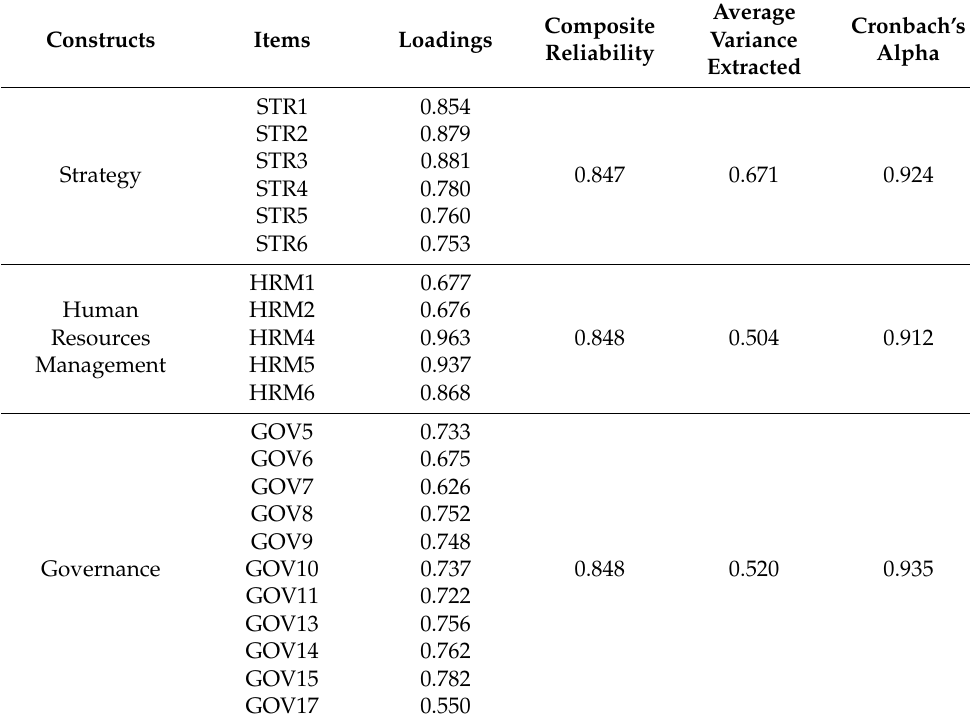
Table 1. Validity and reliability of constructs.